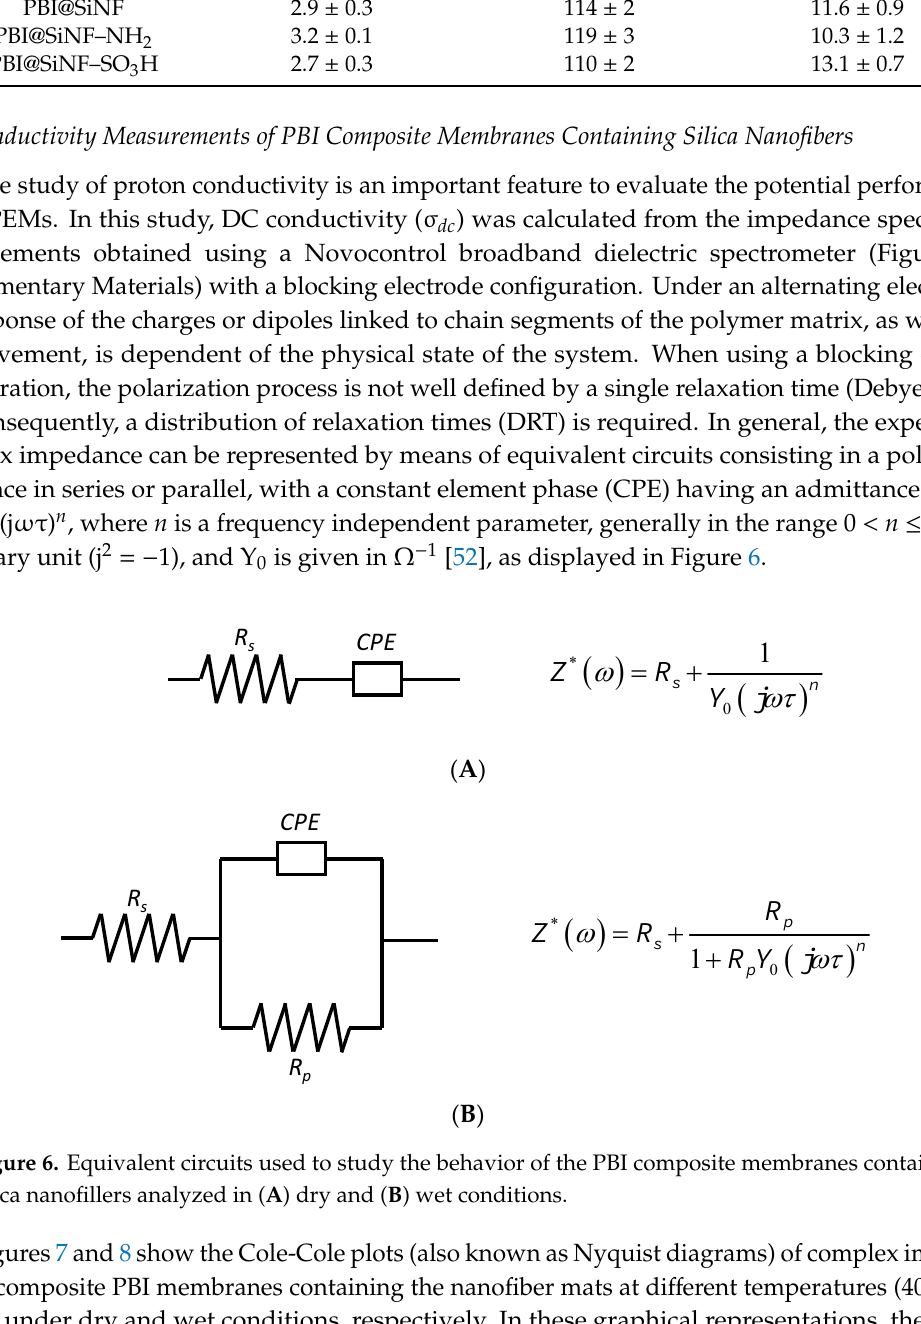
Figure 6. Equivalent circuits used to study the behavior of the PBI composite membranes containing silica nanofillers analyzed in ( A ) dry and ( B ) wet conditions.